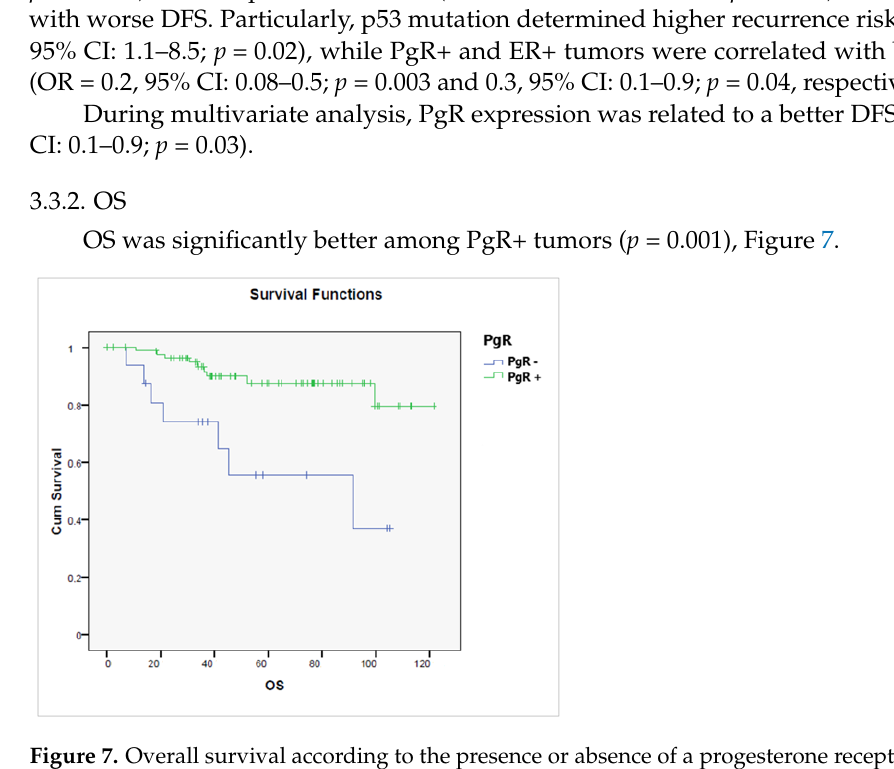
Figure 7. Overall survival according to the presence or absence of a progesterone receptor (PgR+ vs. PgR − , p = 0.001).